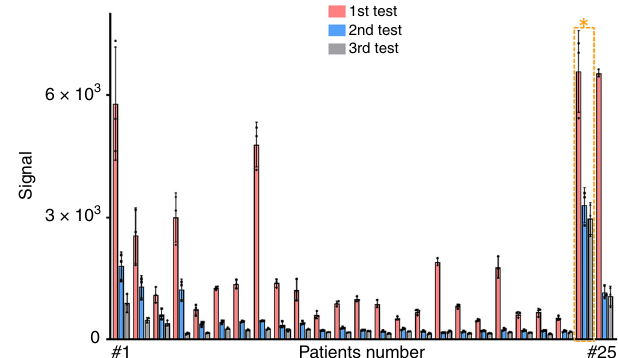
Fig. 5 Serum tests for monitoring after PCI using cTnI. Tri-tests of cTnI for all 25 patients in a period of 10 days, concluding 1st test results before PCI in red, 2nd test results on day 5 after PCI in black and 3rd test results on day 10 after PCI in blue. All experiments were conducted with n = 3; mean ± s.d. * referred to the MI patient (#24, in the yellow box) that needed observation for a longer time after PCI. Source data are provided as a Source Data fi